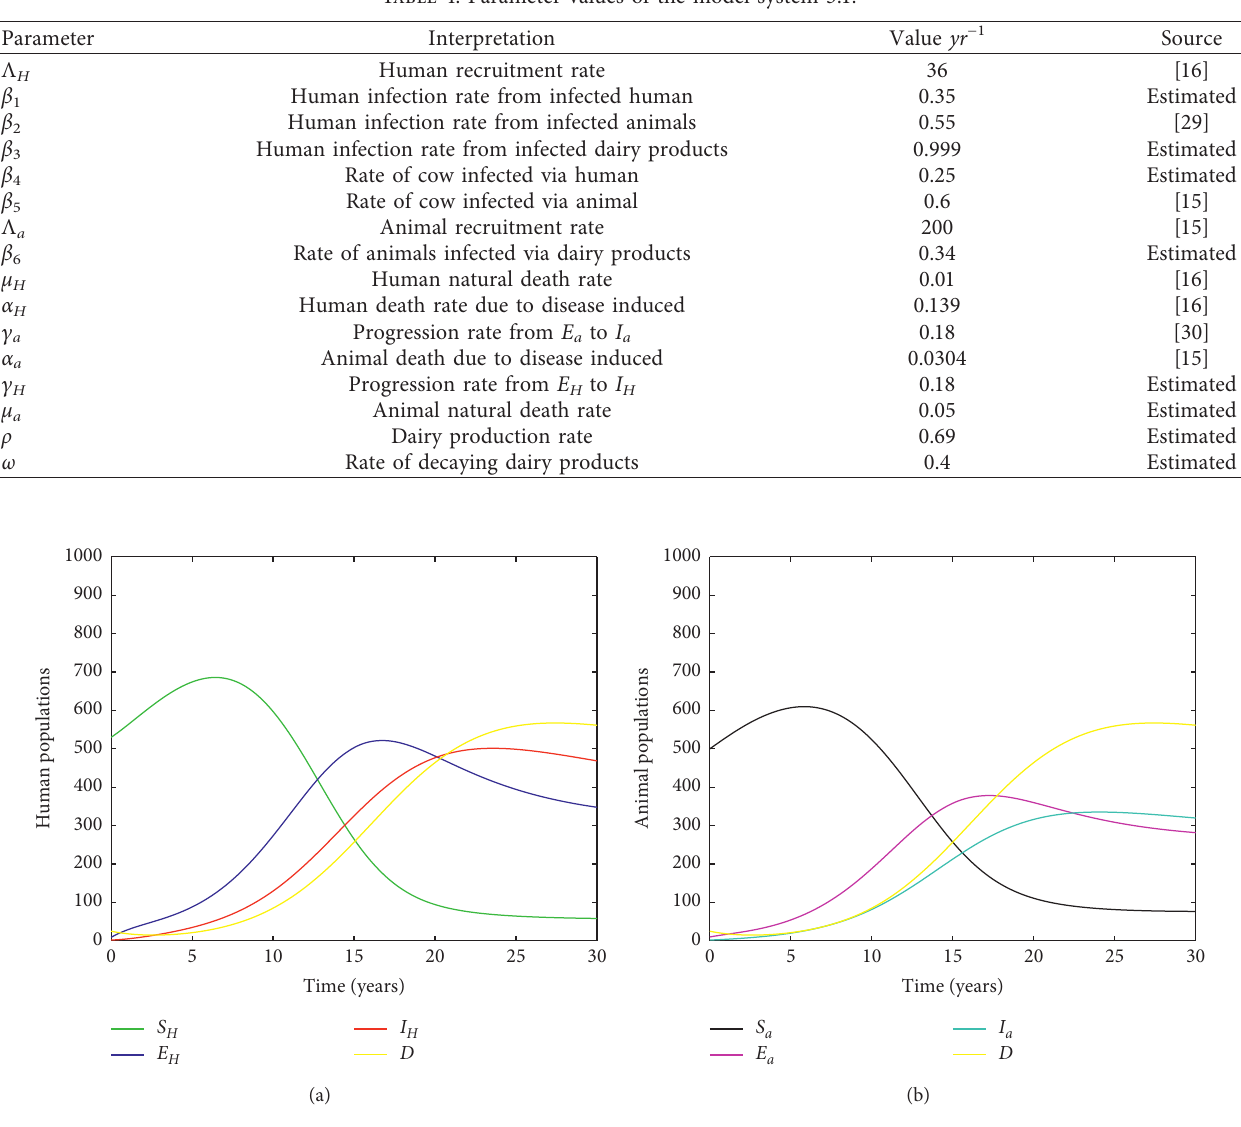
Table 4: Parameter values of the model system 3.1.